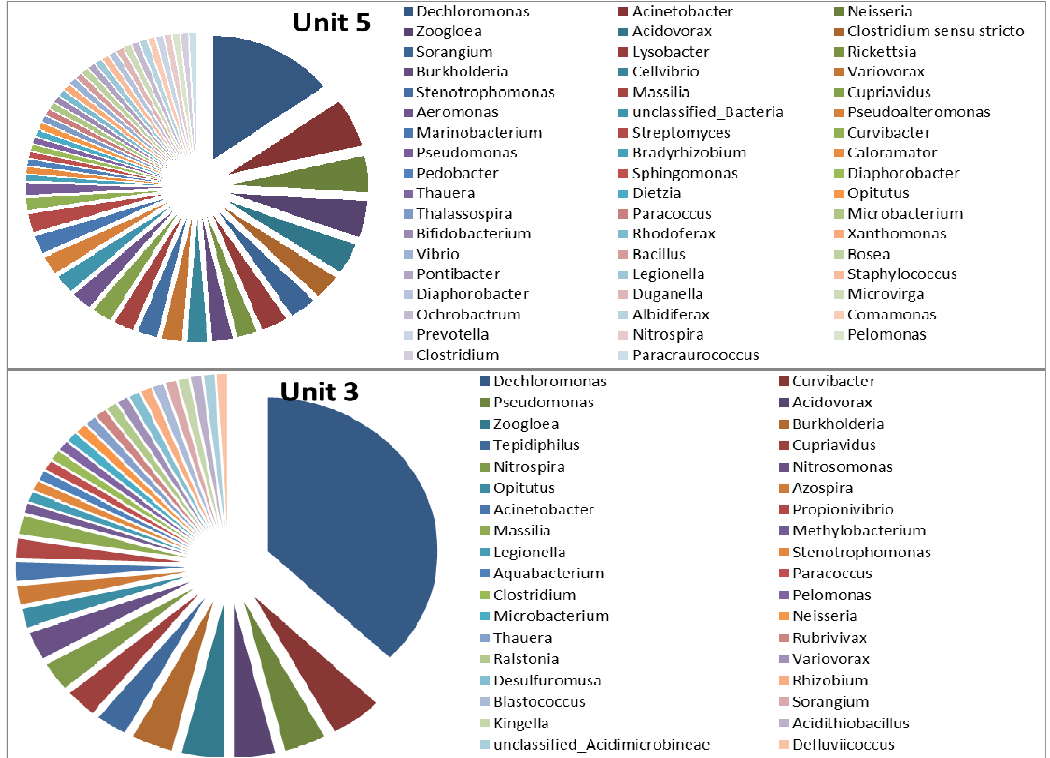
Figure 9. Microbial diversity (by genus) of anaerobic zones in Unit-5 and Unit-3 of the Northern Wastewater Treatment Works, Johannesburg, South